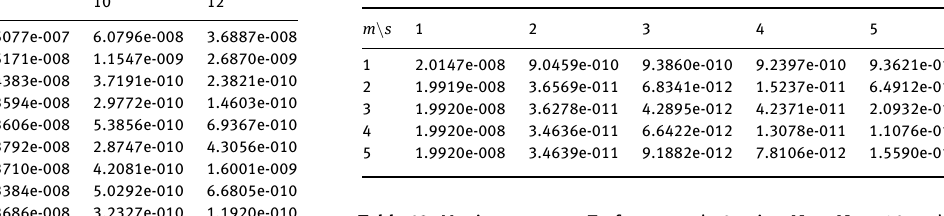
Table 10: Maximum errors E N for example 2 using N t = N x = 10 and t = 1.